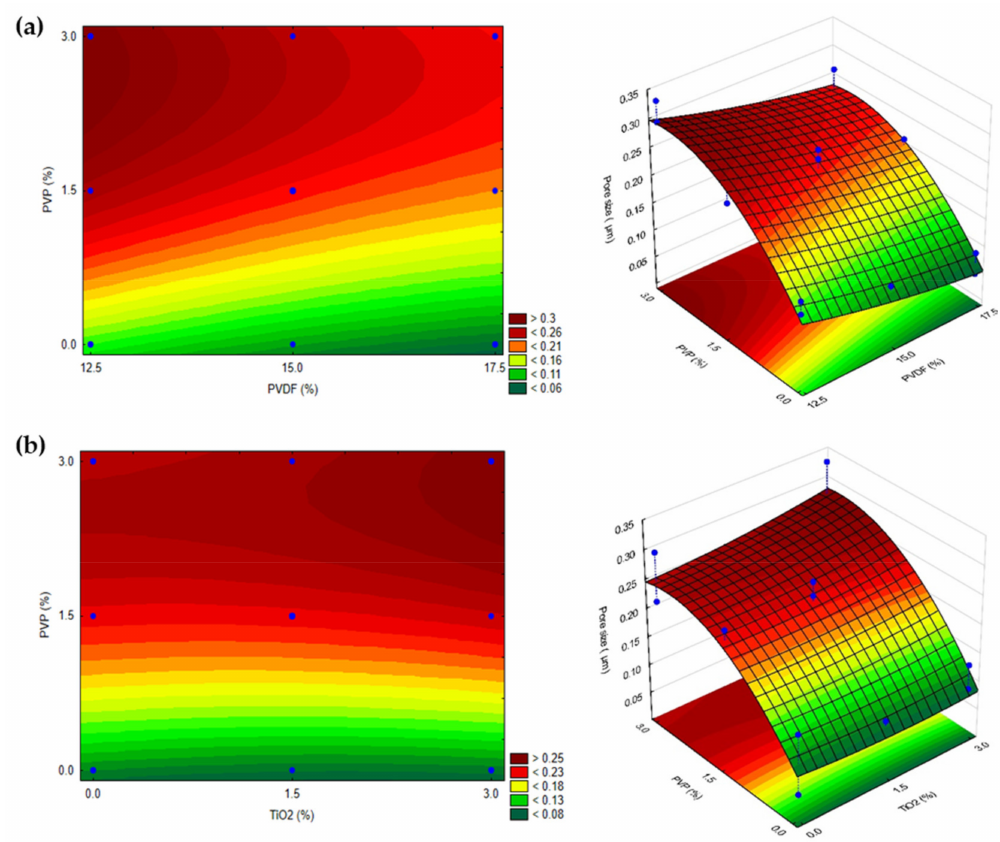
Figure 2. 2 and 3-dimensional surfaces representing the correlation between pore size and PVP concentration in TiO 2 -modified membranes using different amounts of ( a ) PVDF and ( b ) TiO 2 . Blue dots represent experimental values within the investigated design space ( n =